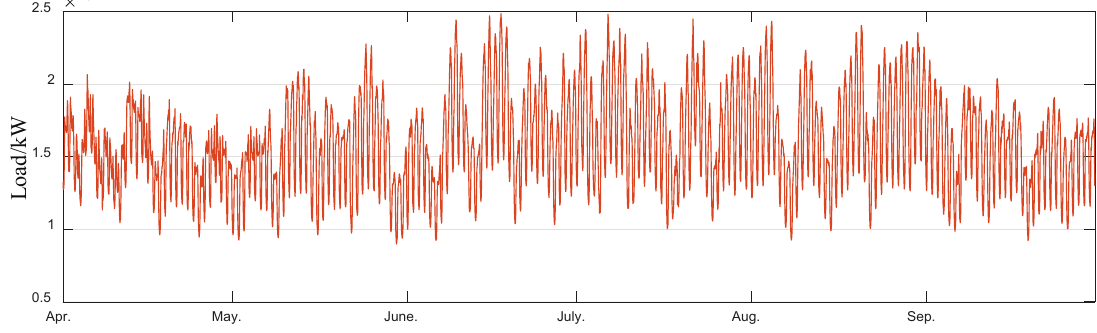
Figure 8. Load data of the second and third quarters in